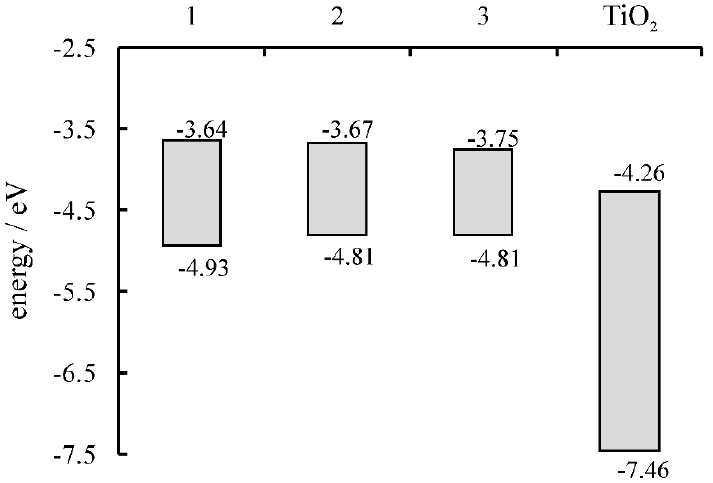
Figure 3. HOMO–LUMO energy levels for the synthesized fullerene derivatives ( 1 – 3 ) and TiO 2 .